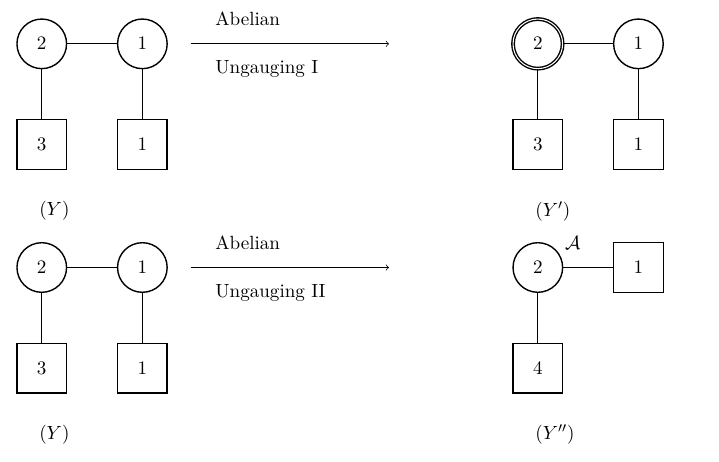
Figure 41 . The figure shows the two quiver gauge theories — Y 0 and Y 00 — that arise from the Abelian ungauging operation on the theory ( Y ) for two different choices of P . The line labelled as A denotes a hypermultiplet in the rank-2 antisymmetric representation of the gauge group U(2) and has charge 1 under the flavor symmetry group U(1) . It is charge 2 under the U(1) subgroup of U(2) , and uncharged under the SU(2)